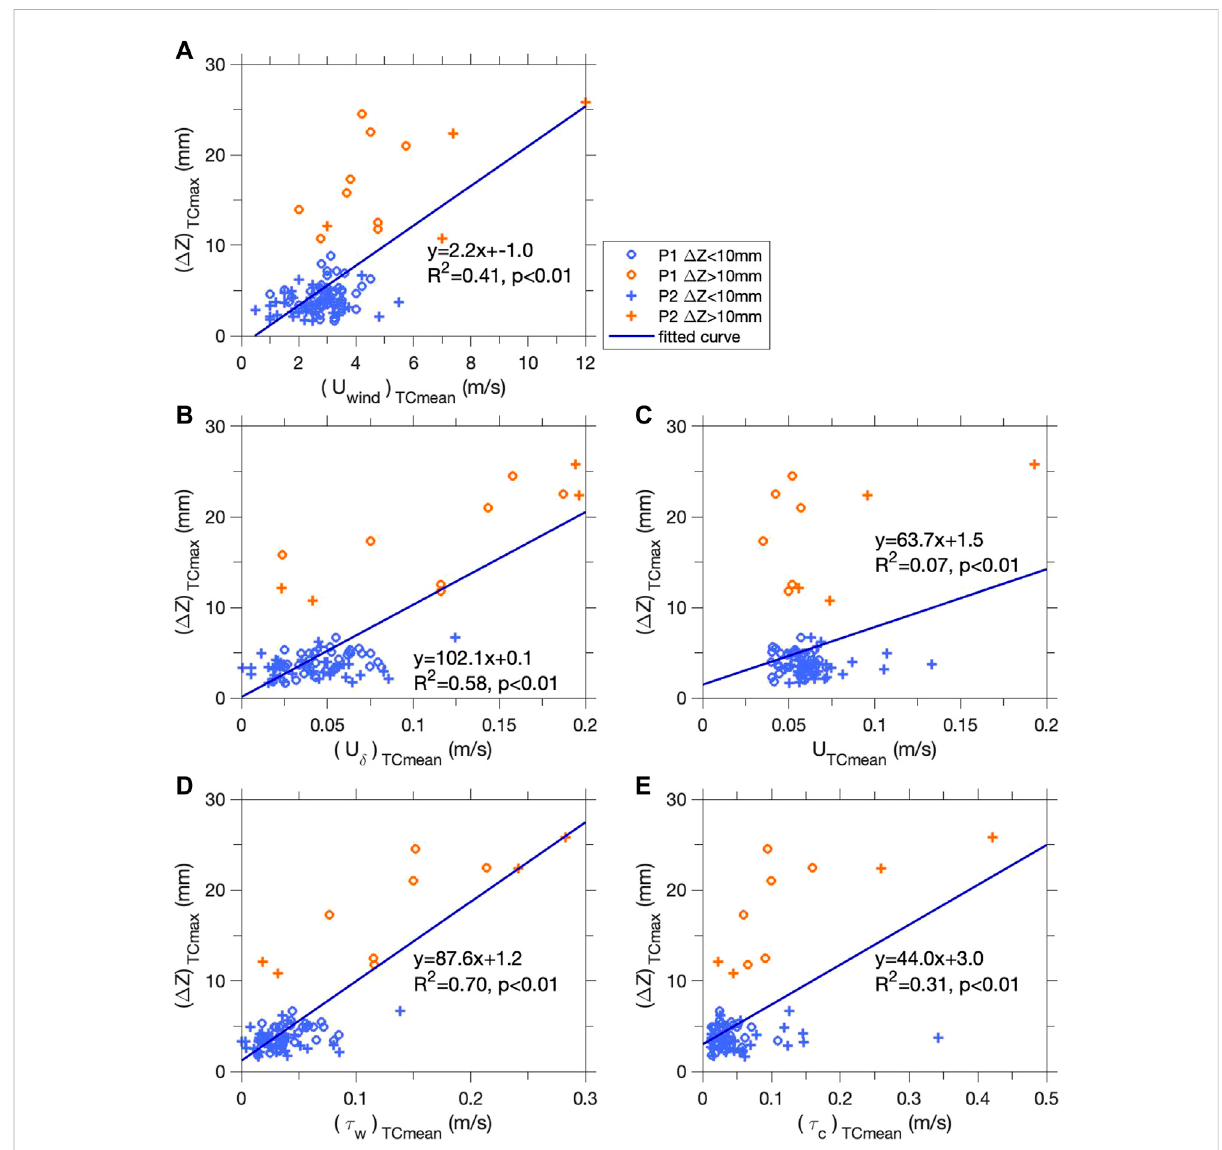
FIGURE 7 Relationship between the maximum intratidal bed-level variation, Δ Z , and (A) mean wind speed during each tidal cycle ( U wind ) TCmean , (B) tidal- averaged bottom orbital velocity, ( U δ ) TCmean , (C) tidal-averaged current velocity, U TCmean , (D) tidal-averaged wave-induced bed shear